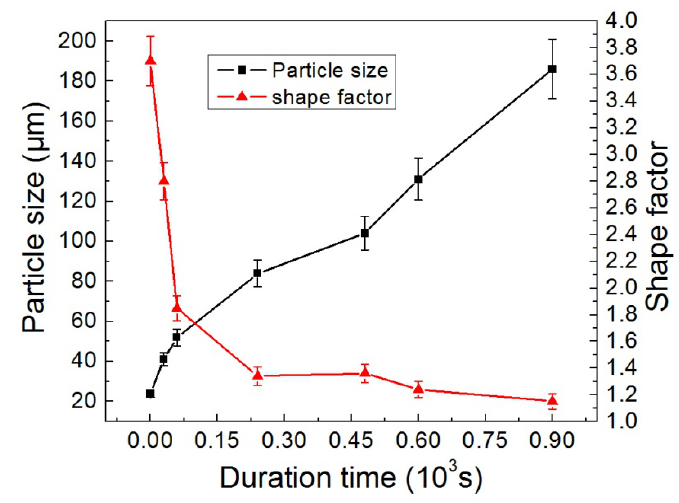
Figure 7. Effect of duration time on particle size and shape factor of primary α -Mg phase.